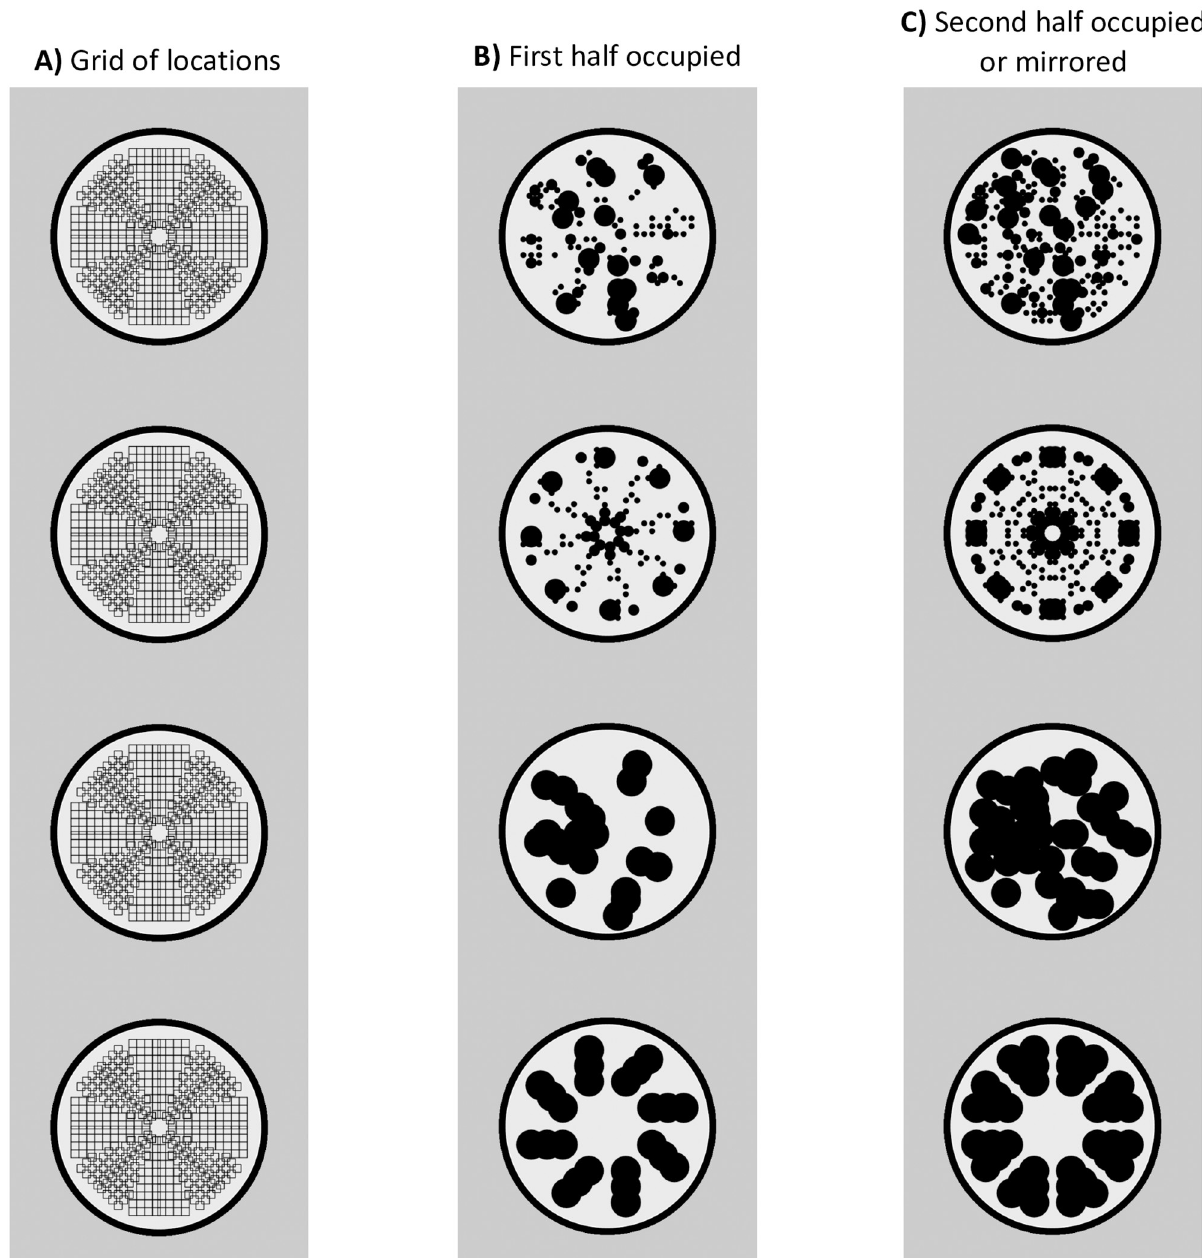
Fig 15. Stimulus construction steps. A) An in implicit grid of possible locations was created. B) The grid was probabilistically occupied with black dots. For complex stimuli, the black dots were small, medium or large (top two rows). For simple stimuli, all black dots were large (lower two rows). C) For random patterns each segment half was occupied independently. For reflectional pattern, each half was